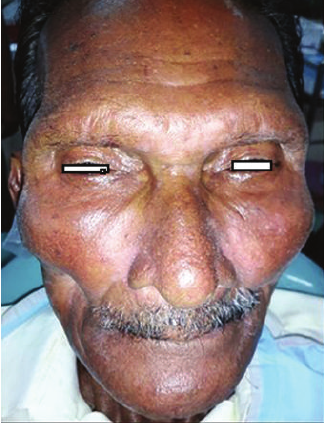
Figure 3: Brain MRI showing cerebral and cerebellar atrophy.